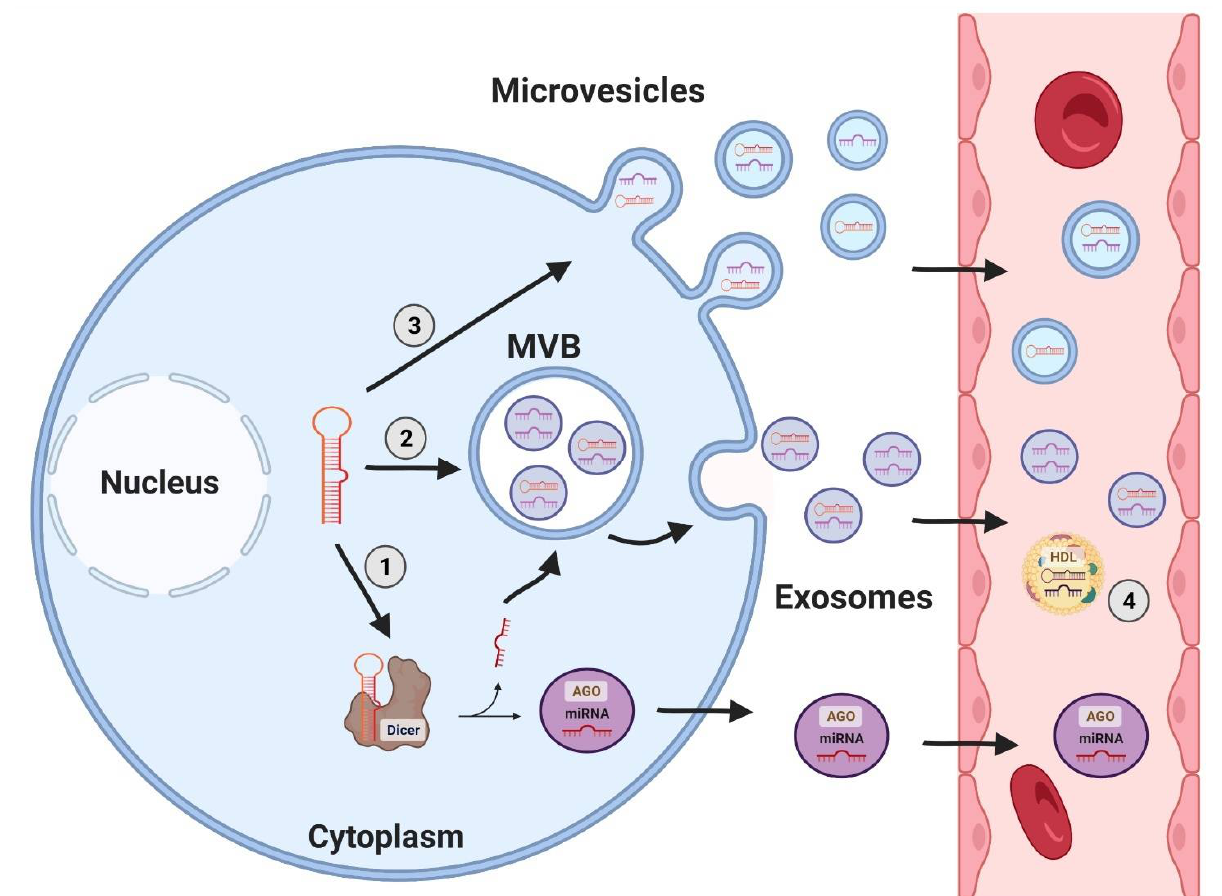
Figure 2. Circulating miRNAs. Circulating miRNAs arise in different ways: (1) Pre-miRNAs leave the nucleus and enter the classical processing pathway, where they might be secreted in their free form, by an unknown route, and circulate associated with high-density lipoprotein (HDL) and Argonaute proteins (AGO, as demonstrated in number (4). Alternatively, they might be incorporated into multivesicular bodies (MVB) and secreted into exosomes; (2) pre-miRNAs are integrated into MVBs and released through exosomes, finishing their processing in target cells; (3) both pre-miRNA and mature miRNA can be integrated into microvesicles that sprout from the cell surface and reach the bloodstream.